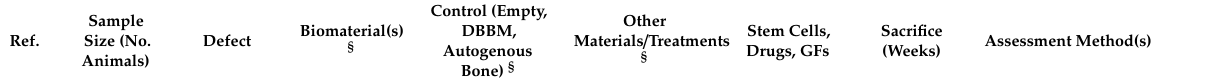
Table 6. Summary of the characteristics and main results of studies in rats (n =